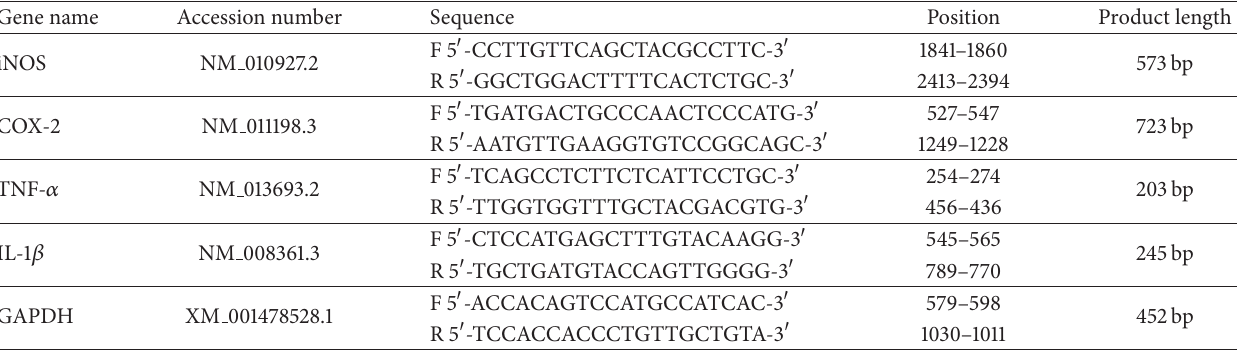
Table 1: List of primers used for